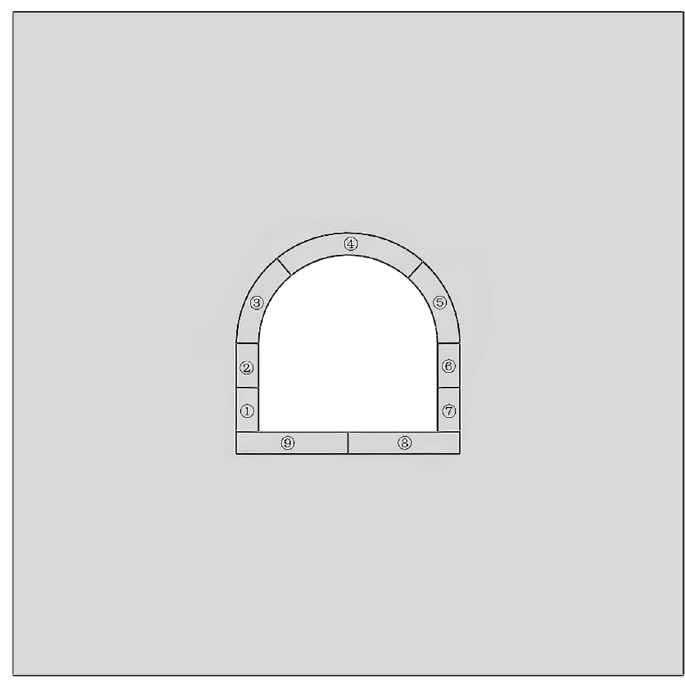
Figure 1. Different parts of the tunnel system. The upper boundary of the model is subject to a mean pressure µ p of 20 MPa with a standard deviation σ p of 4.13 MPa. The constitutive rock model is the ideal elastic brittleness model [12]. At the left boundary, the lateral pressure coefficients λ are 0.5, 1, and 2. Lateral pressure coefficients of 0.5, 1, and 2 are obtained based on previous research and engineering experience [21,23]. In tunnel engineering, the lateral pressure coefficients of 0.5, 1, and 2 are representative. The right and lower boundaries are fixed, as shown in Figure 2